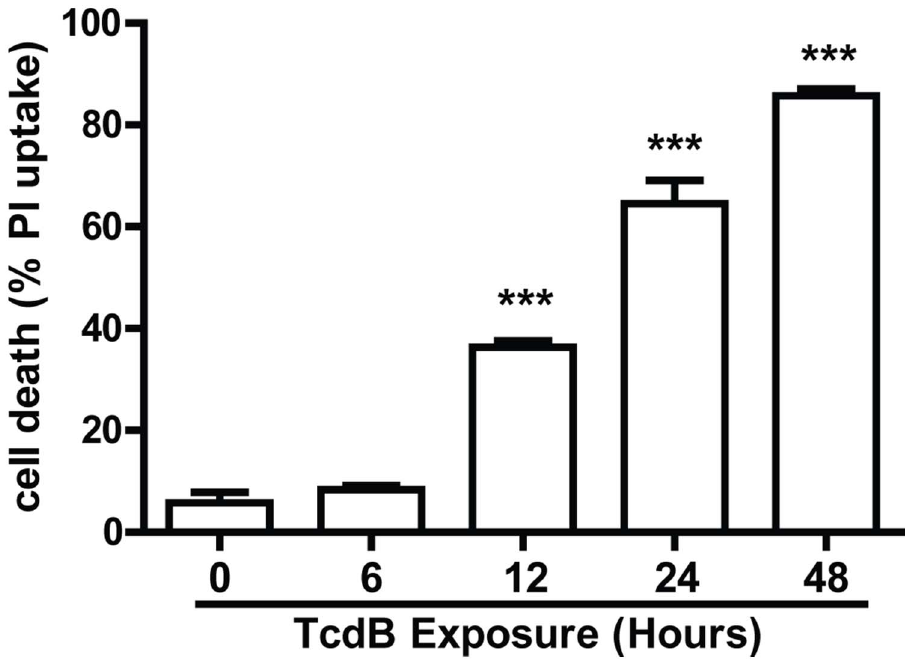
Figure 1. Cell death of TcdB-intoxicated CT26 cells. CT26 cells were exposed to 500 ng/ml of TcdB for different time, and cell viability was measured by the PI staining as described in Material and Methods. Propidium iodide-positive cells were analyzed by Flow cytometry. The data shown represent one of three independent experiments. ***represents P , 0.001 vs. control (unpaired two-tailed t- test). Error bars, SEM.